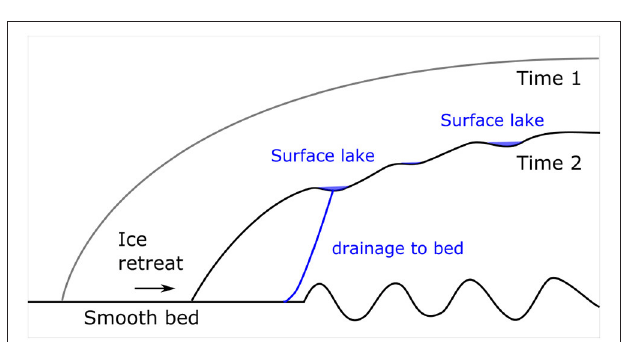
FIGURE 12 | Concept of how an evolution of ice sheet geometry over time modifies the transfer of basal variability to the surface, and thus the spatial structure of surface